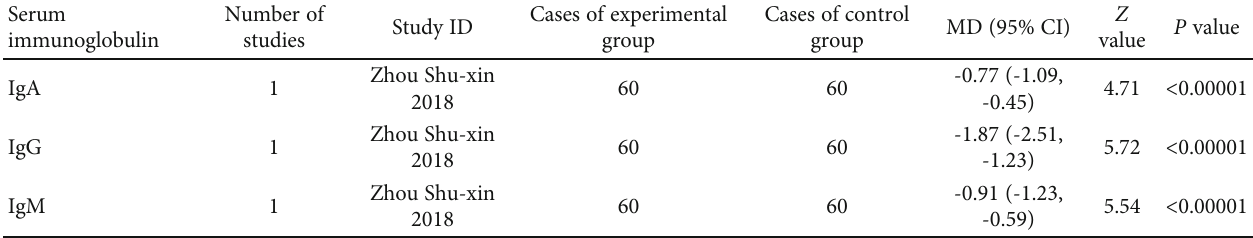
Table 7: ACU combined with routine treatment vs. routine treatment on serum immunoglobulin.